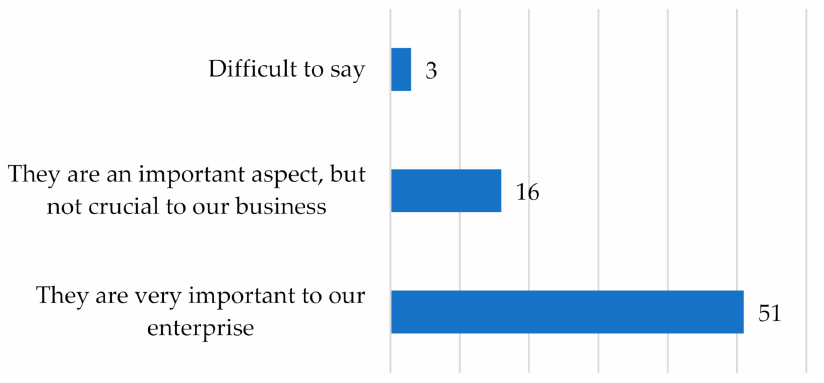
Figure 2. Impact of Industry 4.0 technology on business